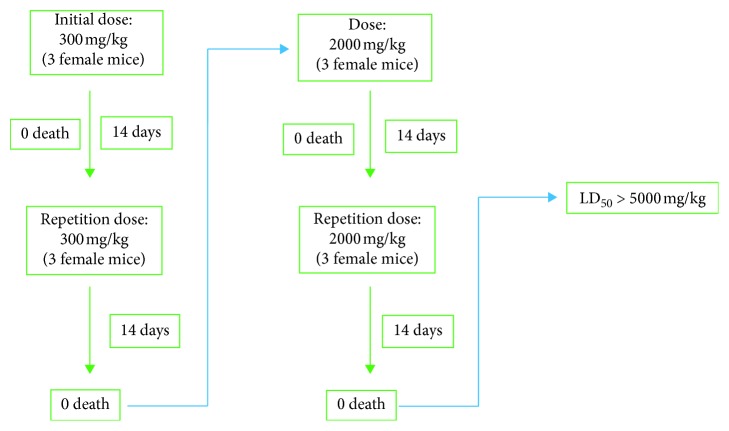
Determination of the LD50 of 1-alkyl-2-alkylthio-1H-benzimidazoles 2–5.